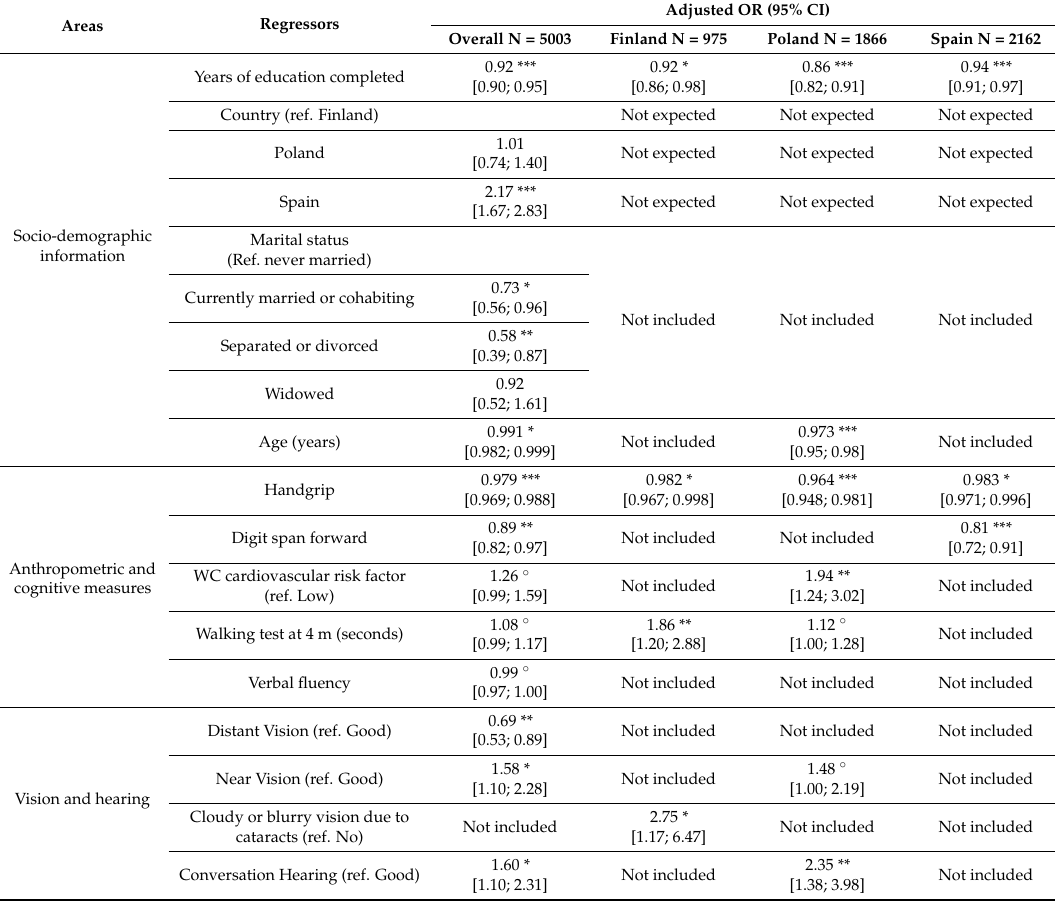
Table 2. Regressors of the selected multiple models divided by